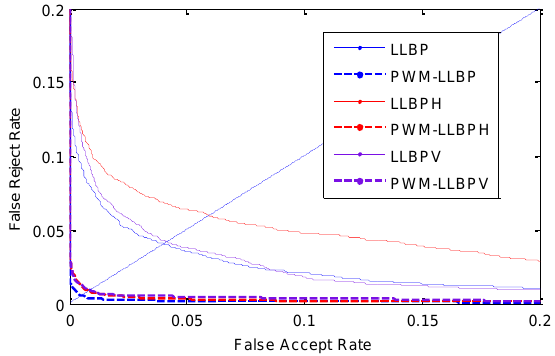
Figure 13. ROC curves by different methods.